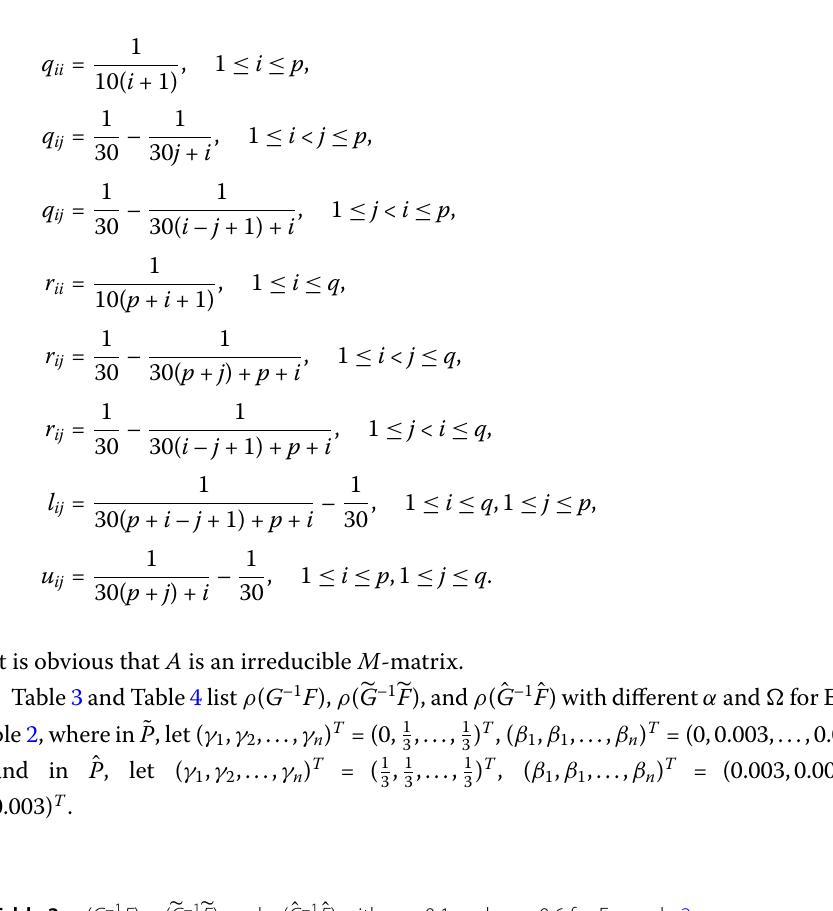
Table 3 ρ ( G –1 F ), ρ ( (cid:9) G –1 (cid:9) F ), and ρ ( ˆ G –1 ˆ F ) with α = 0.1 and ω i = 0.6 for Example